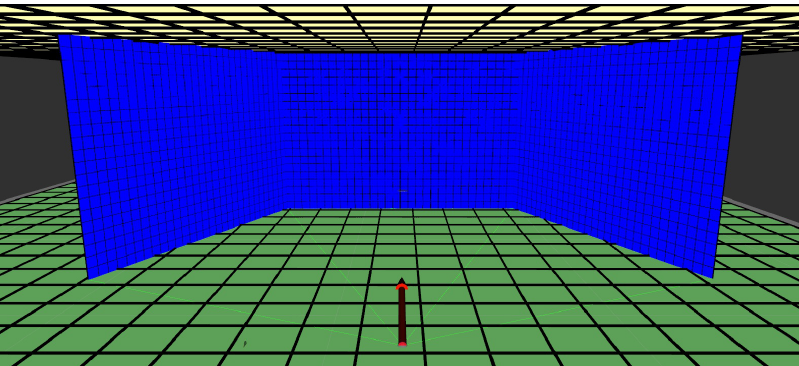
Figure 5. Empty grids for the local map (blue) and global map (green for ground, light yellow for ceiling) of the proposed mapping